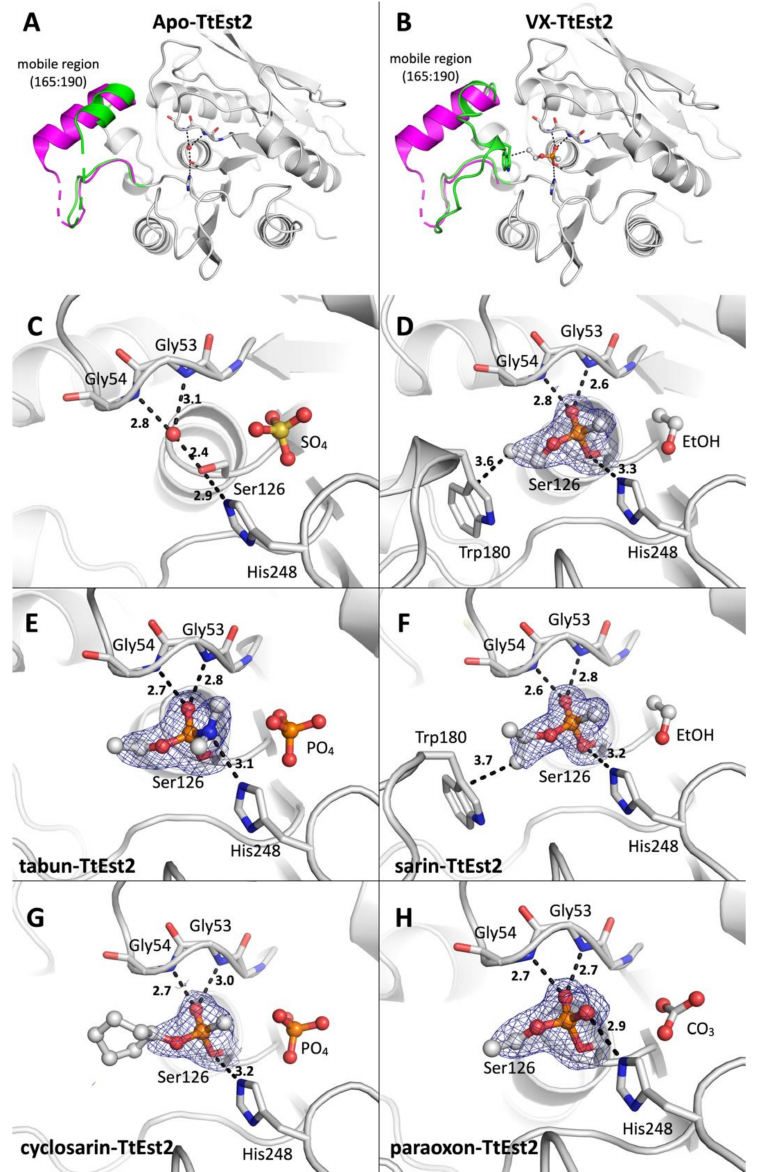
Figure 4. X-ray structures of apo-TtEst2 and its OPNA inhibited forms. ( A ), Overall structure of TtEst2 in the apo form. The mobile region 165–190 of the previously published structure (pdb 5ao9) is in magenta, and in green for the present work (pdb 7bfn). ( B ), Overall structure of TtEst2 phos- phonylated by VX (7bfo). Mobile region 165–190 is highlighted as precedingly. ( C – H ), Close-up views of the TtEst2 catalytic site, with Ser126 and His248 represented as sticks, as well as Gly53 and Gly54 forming the oxyanion hole. C , apo-TtEst2 (7bfn); ( D ), VX-phosphonylated TtEst2 (7bfo); ( E ) tabun-phosphoramylated TtEst2 (7bft); ( F ), sarin-phosphonylated TtEst2 (7bfu); ( G ), cyclosarin- phosphonylated TtEst2 (7bfv); ( H ) Paraoxon phosphorylated TtEst2 (7bfr). The OPNA and ligands are represented in ball and stick. Nitrogen atoms are in blue, oxygen atoms in red, carbon atoms in grey, sulfur atoms in yellow, and phosphorous atoms in orange. The water molecule embedded in the oxyanion hole in the apo-TtEst is represented as a red sphere. The 2Fo-Fc electron density maps contoured at 1 σ are represented by a blue mesh for